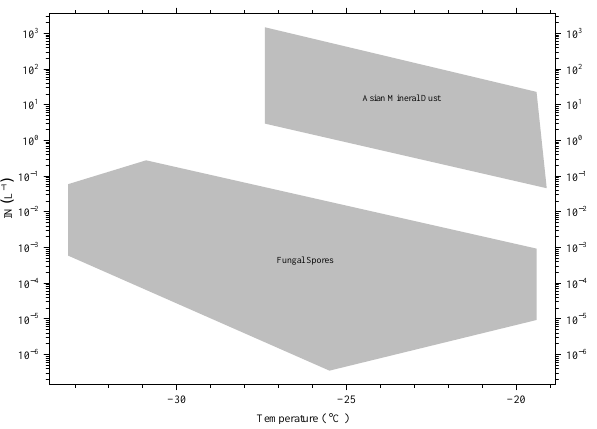
Figure 11. Global annual IN concentrations (L − 1 ) for the fungal spores studied here and for Asian mineral dust (Niemand et al., 2012), estimated using the method of Murray et al. (2012) and Eqs. (4) and (5). The IN concentrations for fungal spores should be considered as upper